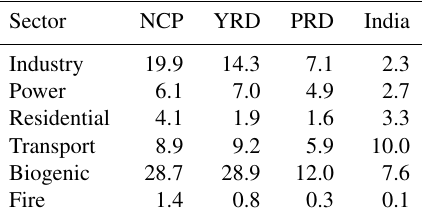
Table 4. Sensitivity of summer (July) daytime O 3 to emission sec- tors for different regions